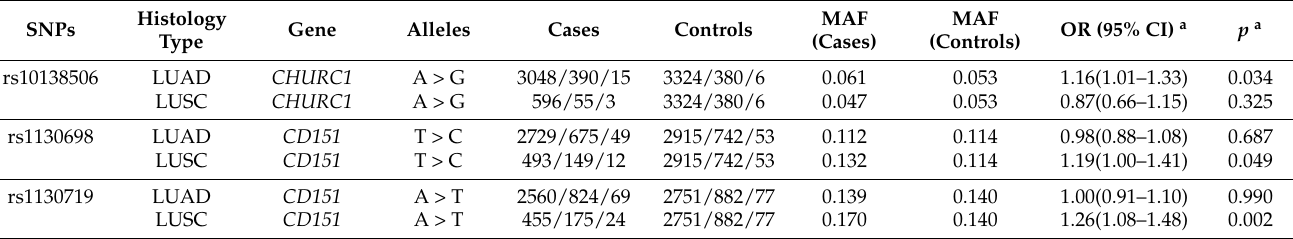
Table 3. Characteristics of the three SNPs in this